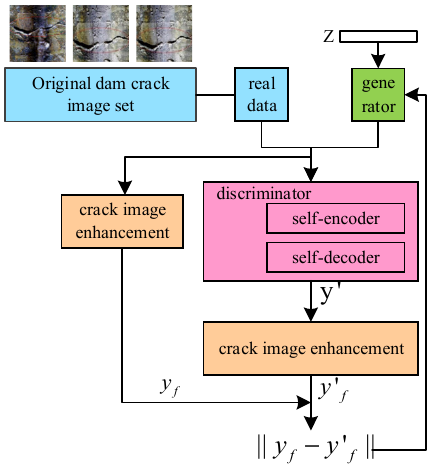
Figure 2. The architecture of CE-GAN.